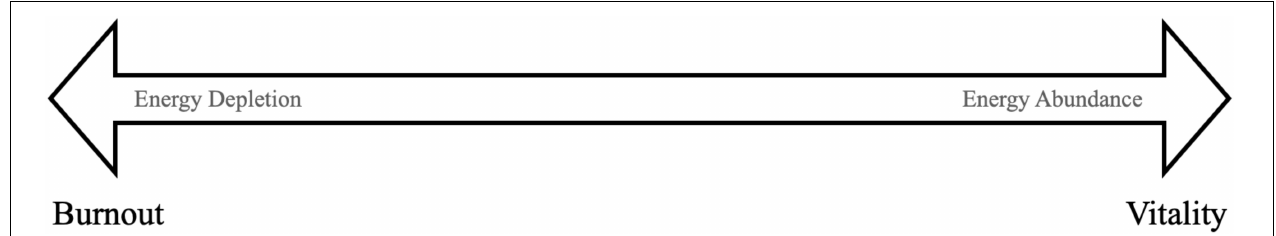
FIGURE 1 | Burnout to